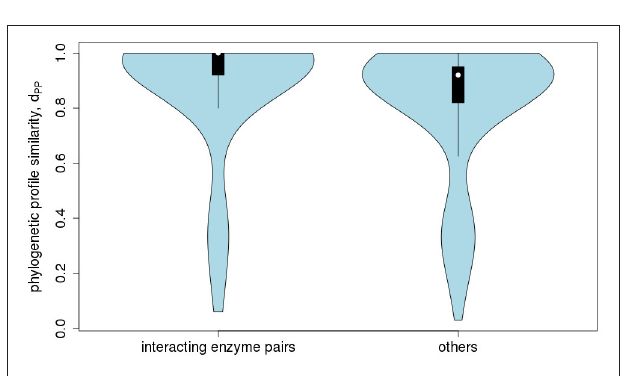
FIGURE 10 | Protein-protein interaction statistic. Violin-plot of the frequency distribution of phylogenetic profile similarity values, d PP , of enzyme pairs encoded in Arabidopsis thaliana reported to physically interact (median = 1) to those pairs not reported to interact (median = 0.92, p < 2.2*10 − 16